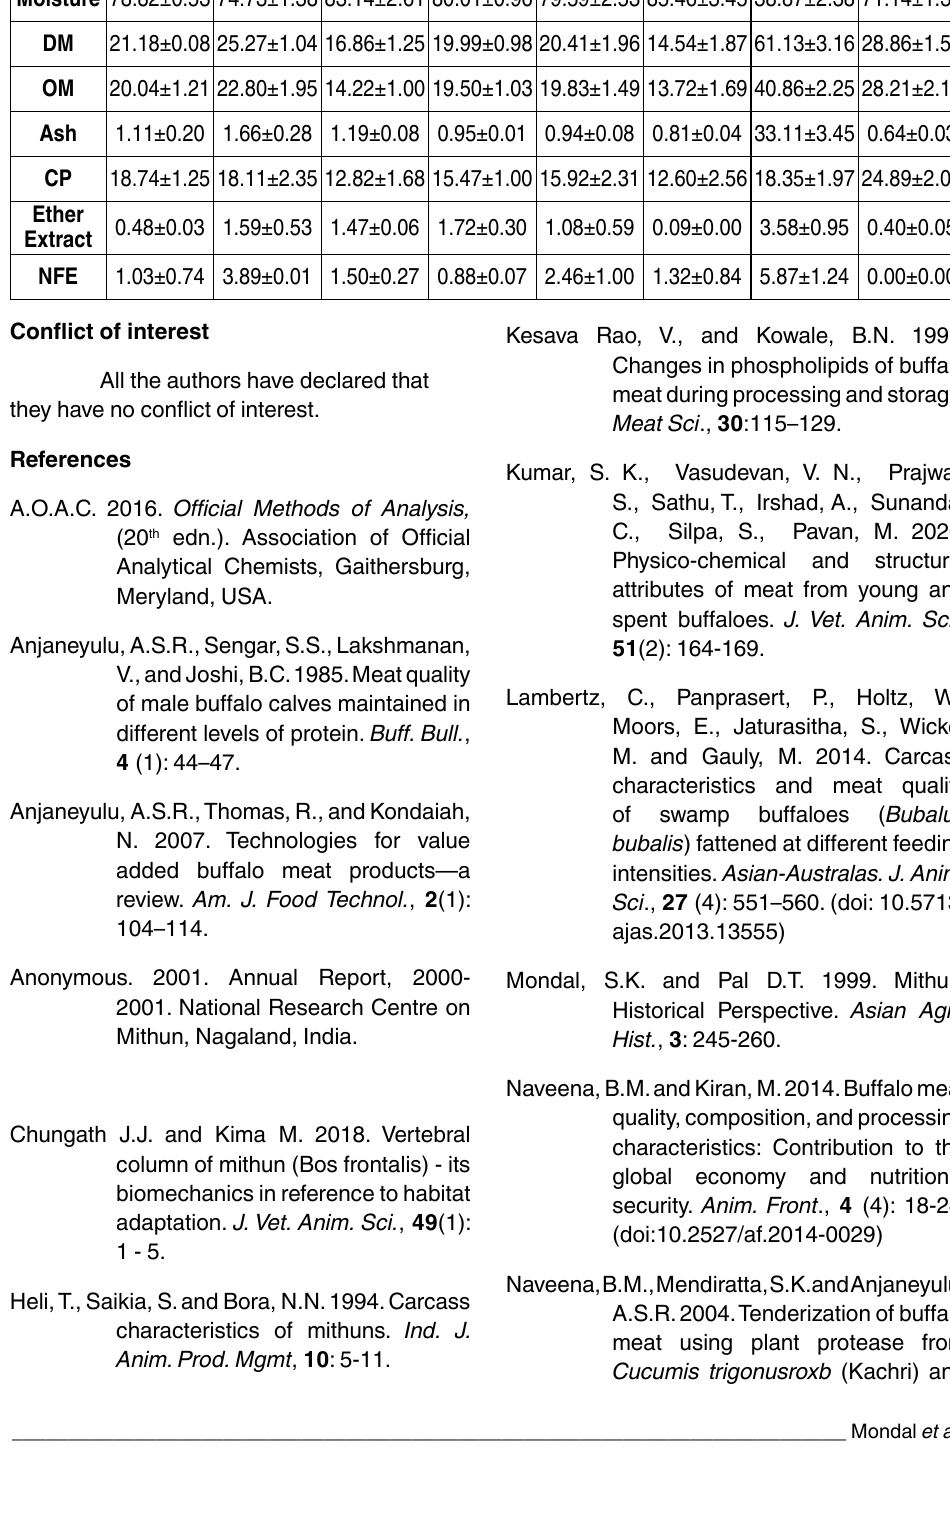
table 3 . Mean (±SE) of chemical composition (on fresh basis) of different body tissues of Mithun (n=12) Nutrient Muscle liver Kidney heart intestine Blood Bone (%)